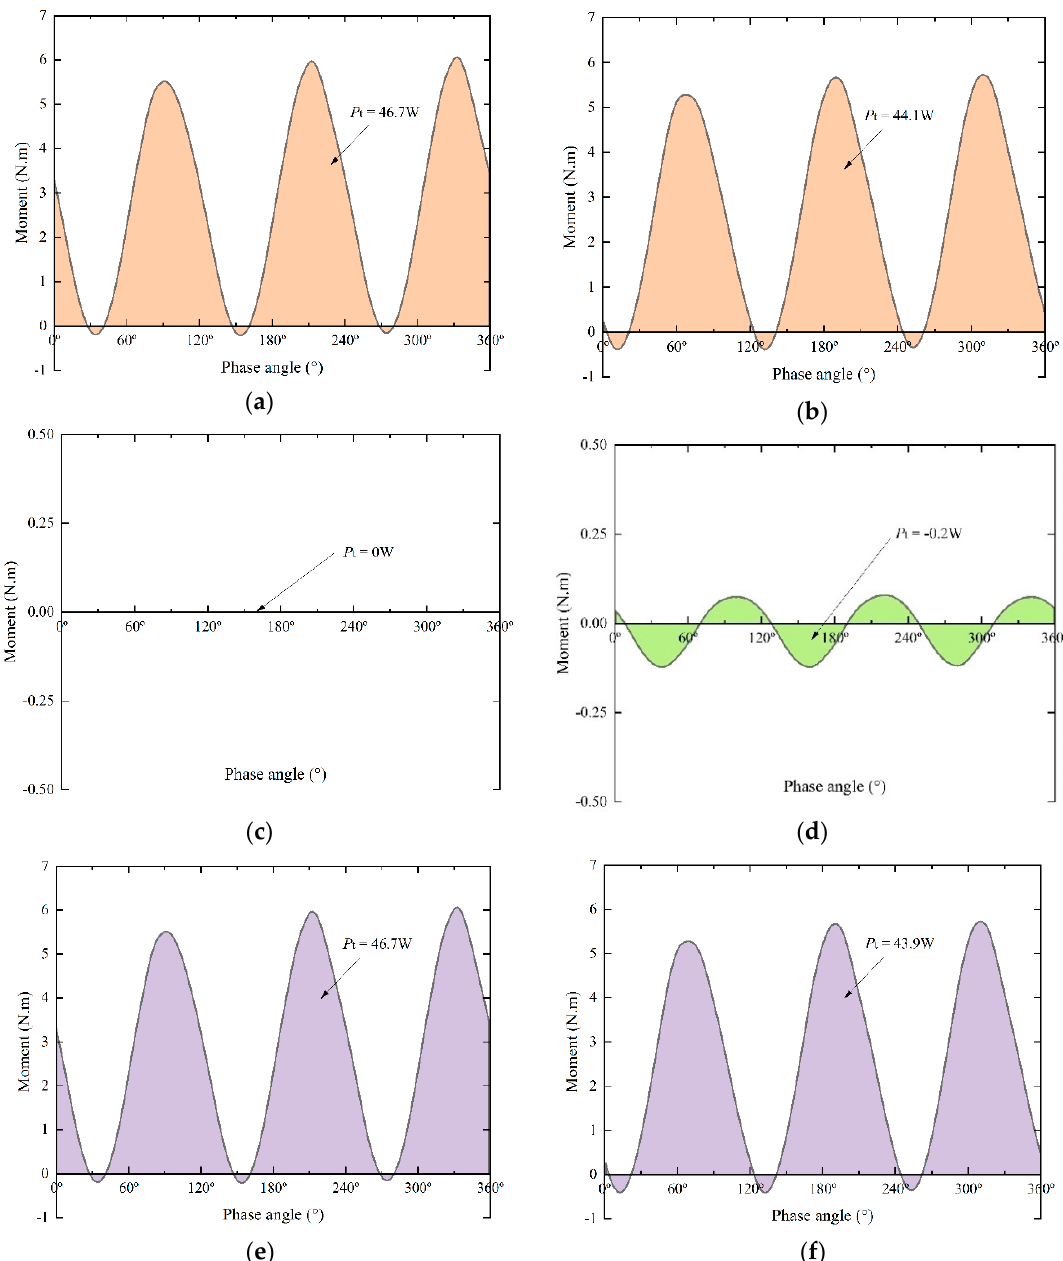
Figure 22. Aerodynamic moments and output powers of the H-type and hybrid VAWTs in one rotation period: ( a , b ) output powers from outer blades of the H-type and hybrid VAWTs, respectively; ( c , d ) output powers from inner blades of the H-type and hybrid VAWTs, respectively; and ( e , f ) output powers from both outer and inner blades of the H-type and hybrid VAWTs, respectively.